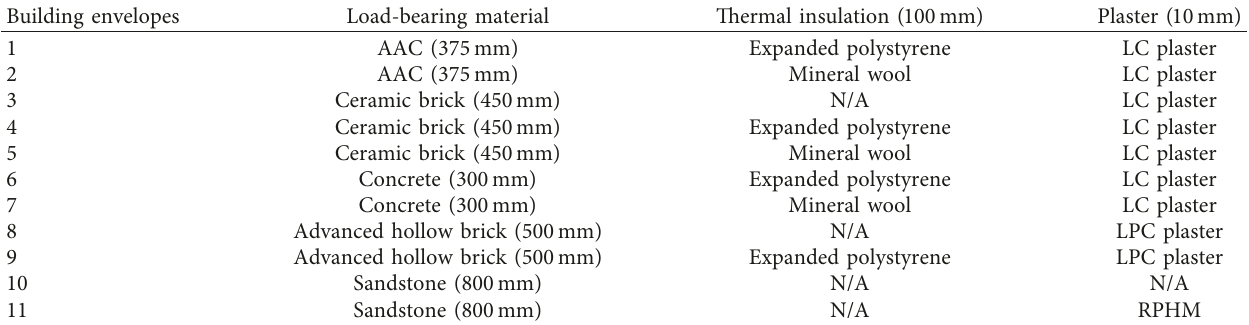
Table 2: List of studied building enclosures.